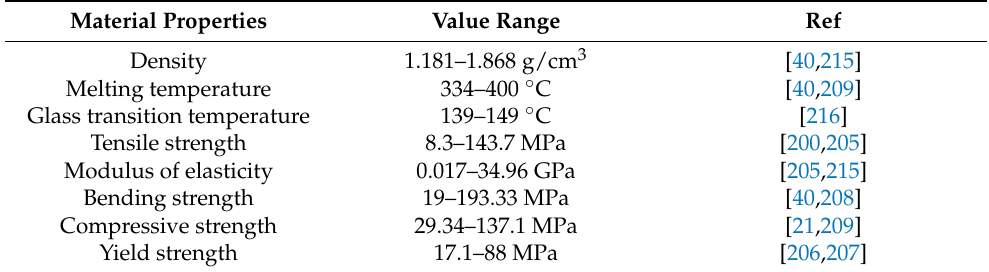
Table 12. Physical and mechanical properties of PEEK and its composite material.